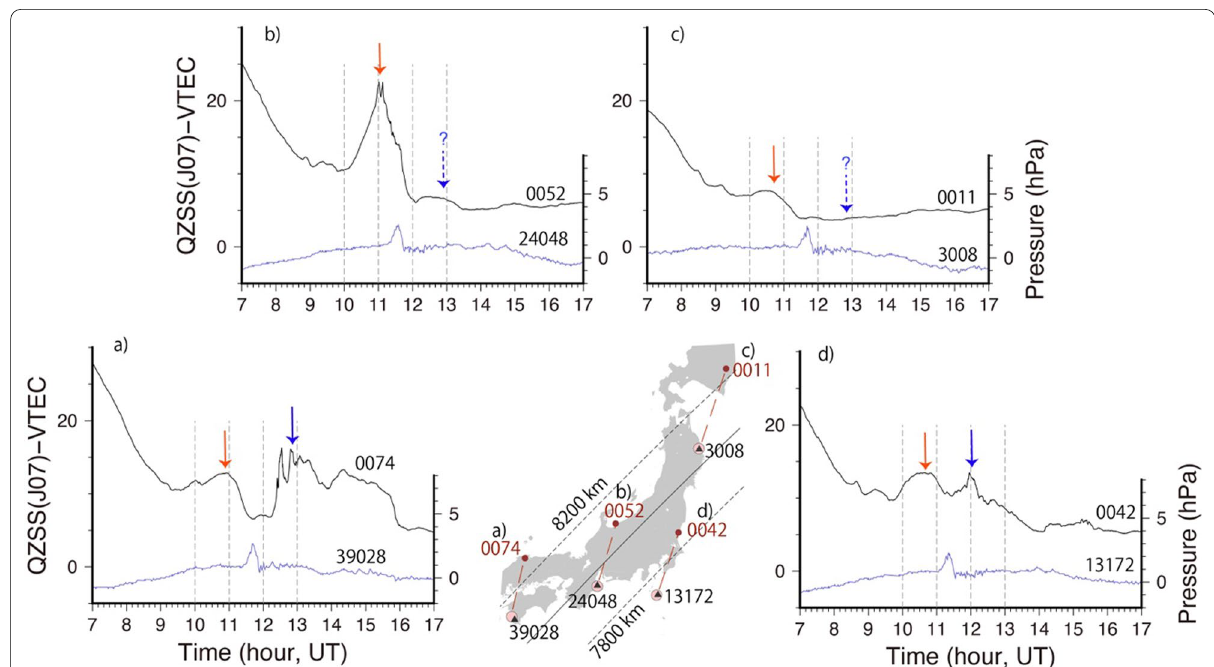
Fig. 8 Comparison of the pressure anomaly (blue) and VTEC (black) obtained using the geostationary satellite J07, on Jan. 15 around the first passage of LW. Positions of GNSS stations (red circles), their SIPs (pink circles), and barometers near SIPs (black triangles) are given in an inset map together with labels a – d . SIPs and corresponding GNSS stations are tied with red dashed lines. Two TEC peaks are evident for a and d (blue and red arrows), but only the first peak (red arrow) is clear in b and c . Vertical dashed lines are drawn for 10, 11, 12, 13 UT to facilitate the comparison of arrival times